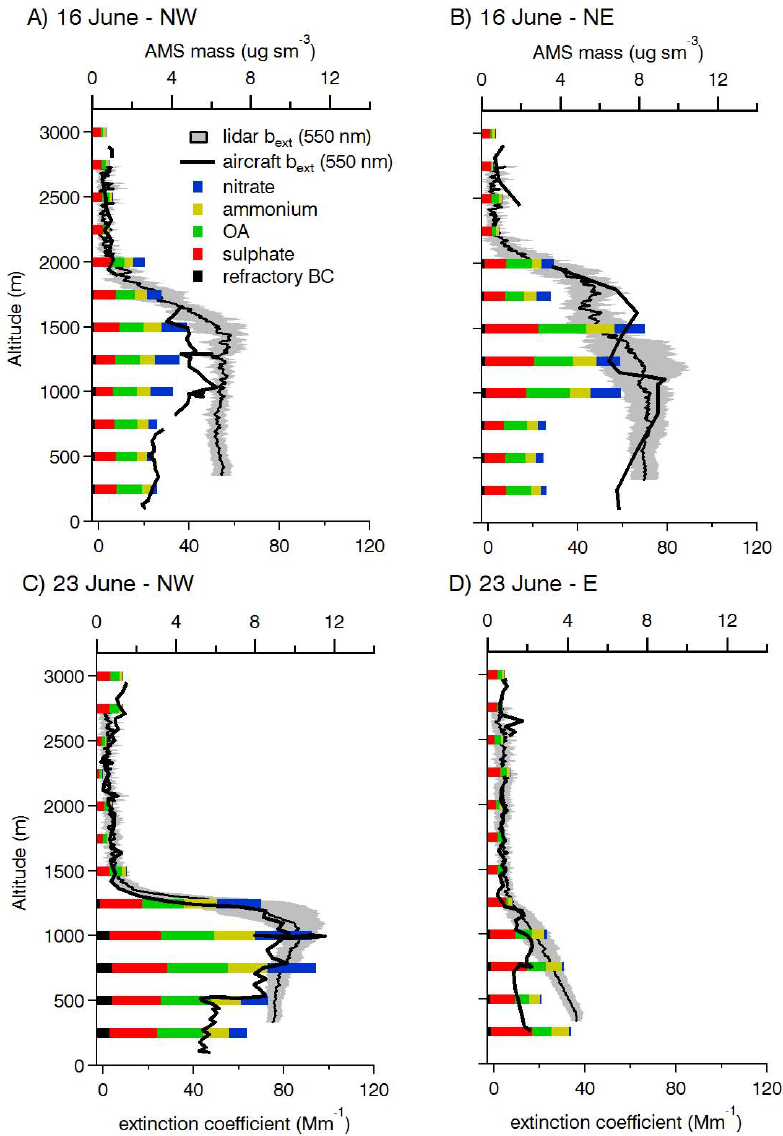
Fig. 14. Aircraft measured aerosol composition (averaged over 250m thick altitude bins, coloured bars) and extinction coefficients (thick black lines) for individual profile segments flown to the (a) northwest and (b) northeast of central London on 16 June and (c) northwest and (d) east of central London on 23 June. Average light extinction coefficients (thin black lines) retrieved from van-based lidar measurements in the vicinity of the aircraft profiles and their variance expressed as a root mean square (shaded grey region) are also